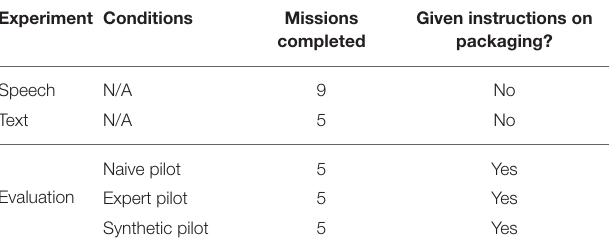
TABLE 1 | Differences between the speech, text, and evaluation experiments. Experiment Conditions Missions